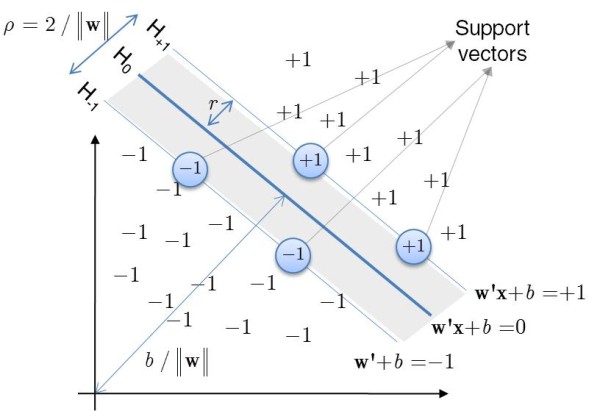
Schematic representation of the optimum hyperplane (H0) by a Support Vector Machine. Diagonal lines represent the classification function for objects {-1} and {+1}. Objects inside the circles are the so-called support vectors verifying w'x + b = -1 or w'x + b = + 1 respectively.